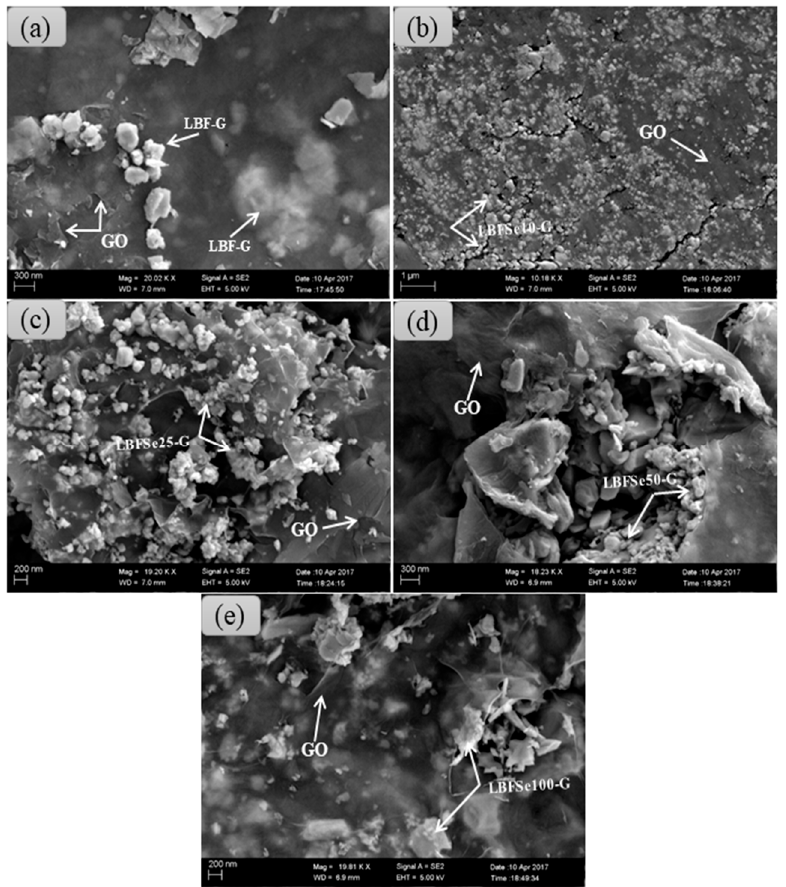
Figure 2. SEM micrographs of (a) Bi 0.92 La 0.08 FeO 3 –graphene oxide (LBF–G), (b) Bi 0.92 La 0.08 Fe 0.90 Se 0.10 O 3 –graphene oxide (LBFSe10–G), (c) Bi 0.92 La 0.08 Fe 0.75 Se 0.25 O 3 –graphene oxide (LBFSe25–G), (d) Bi 0.92 La 0.08 Fe 0.50 Se 0.50 O 3 –graphene oxide (LBFSe50–G), and (e) Bi 0.92 La 0.08 Fe 0.50 Se 0.50 O 3 –graphene oxide (LBFSe100–G).